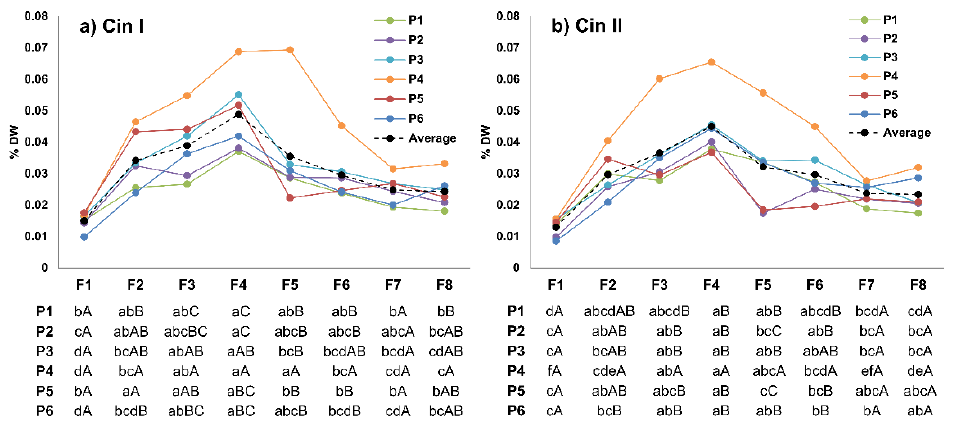
Figure 5. Content of ( a ) cinerin I and ( b ) cinerin II across the eight flower developmental stages in six Dalmatian pyrethrum populations. Lowercase letters refer to differences between phases in the same population, while uppercase letters refer to differences between populations within the same phase.